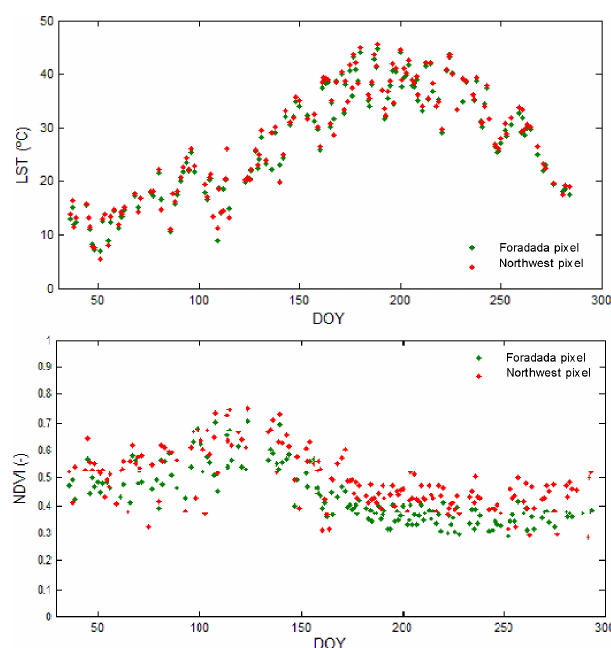
Figure 7. Temporal evolution of LST and NDVI obtained at the Foradada pixel and its neighboring northwest pixel situated 2km